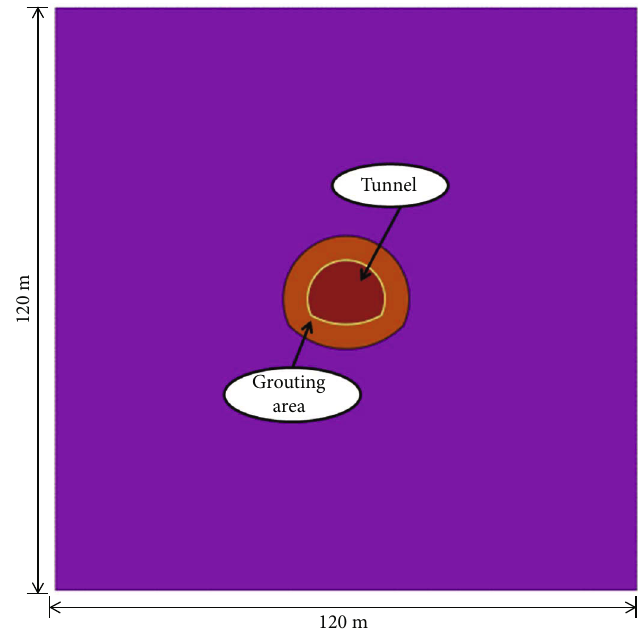
Figure 5: The 2D calculation